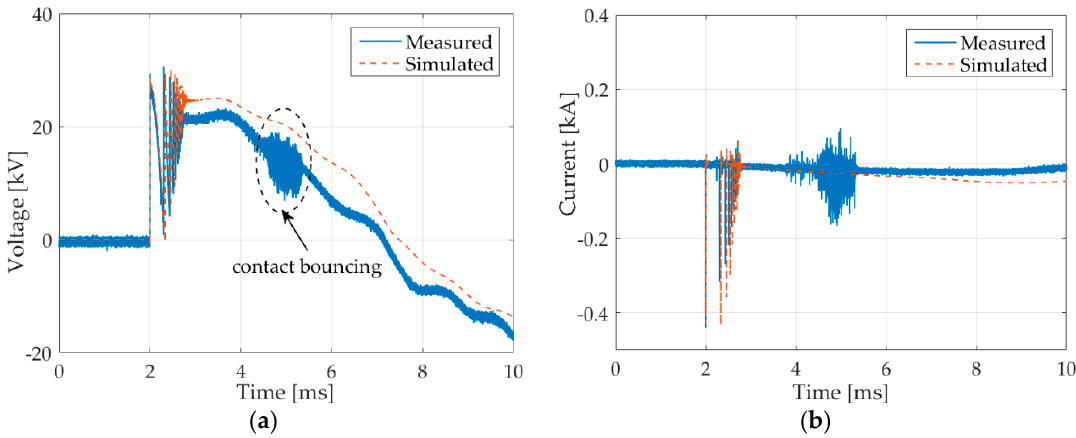
Figure 6. Voltage and current waveforms at the high voltage side of TX2: ( a ) voltages; ( b ) currents.